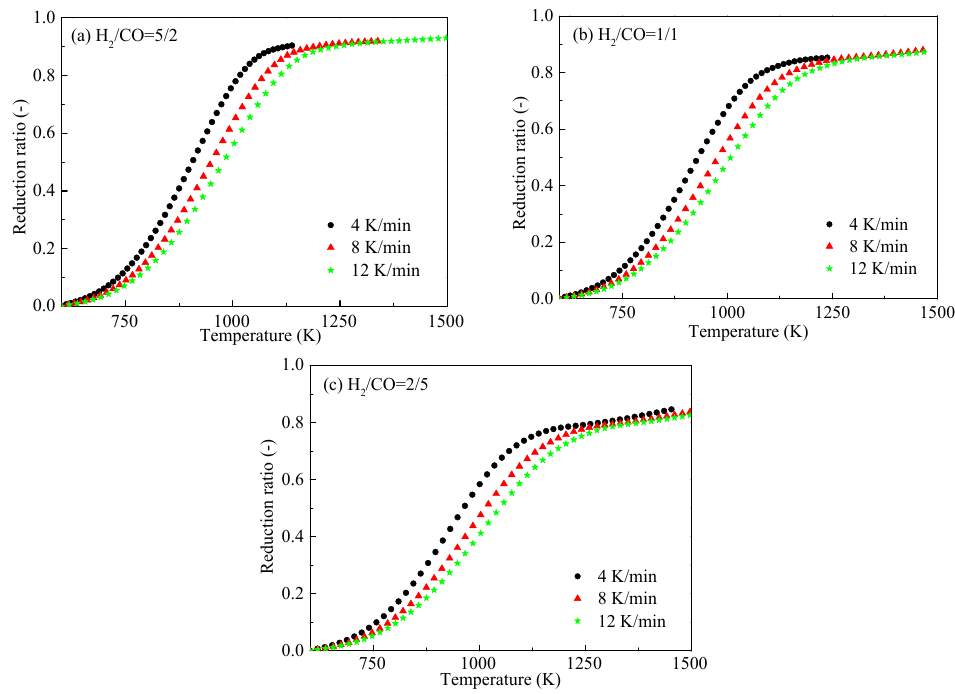
Figure 10. Effects of the heating rate on the non-isothermal reduction ratio under different reducing gas compositions ( a ) H 2 /CO = 5/2; ( b ) H 2 /CO = 1/1; ( c ) H 2 /CO = 2/5.